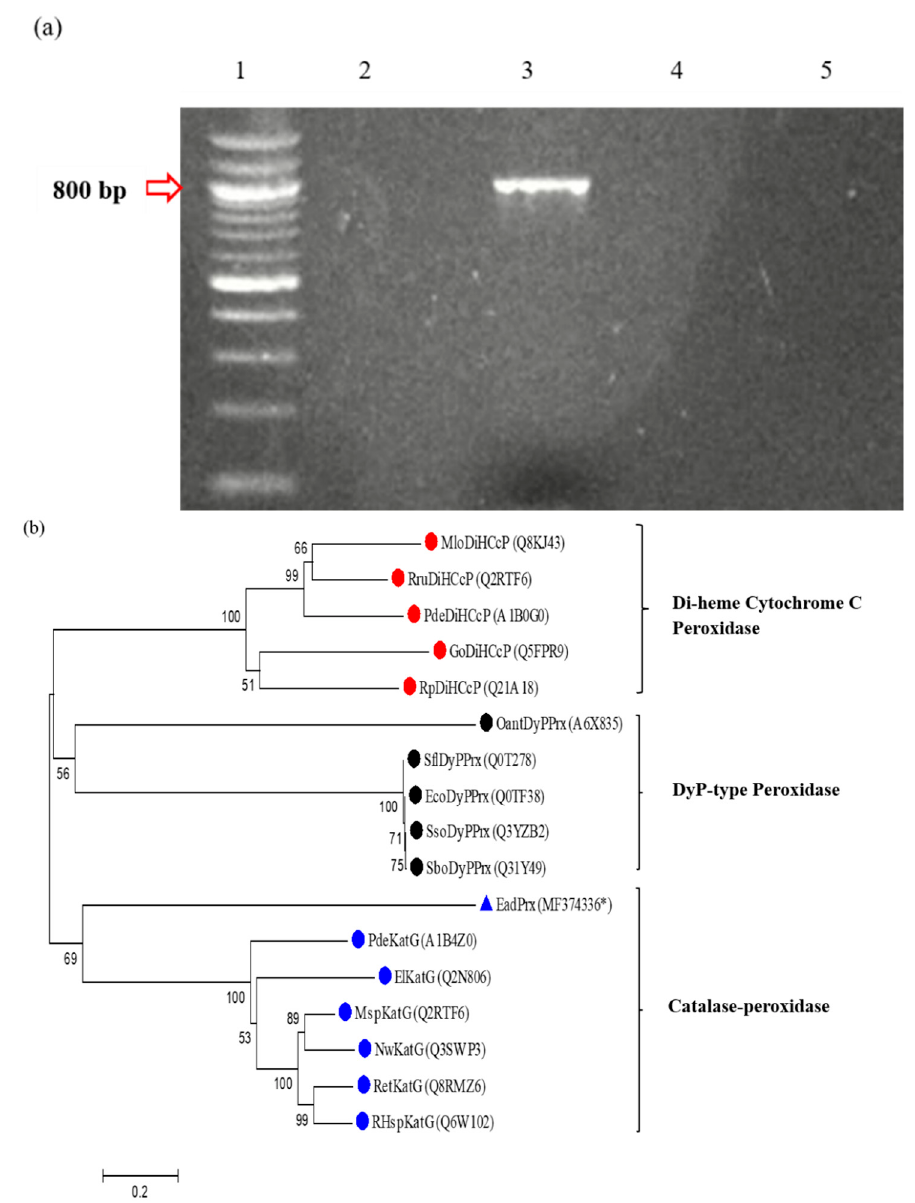
Figure 4. Molecular characterization of peroxidase in Ensifer adhaerens NWODO-2. ( a ) Gel picture of the polymerase chain reaction (PCR)-amplified product. Lane 1:100 bp DNA ladder, lane 2: Empty, lane 3: PCR-amplified product from Ensifer adhaerens NWODO-2, lane 4: Negative control. ( b ) Unrooted phylogenetic tree showing the relationship of Ensifer adhaerens NWODO-2 peroxidase with selected bacterial heme-peroxidases in the PeroxiBase. The percentage of replicate trees in which the associated taxa clustered together in the bootstrap test (1000 replicates) are shown next to the branches. Red tips indicate Di-heme cytochrome C peroxidase (DiHCcP) family, black tips indicate DyP-type peroxidase family, while the blue tips represent catalase-peroxidases. The blue triangular tip indicates the protein sequence obtained in this study (EadPrx). The UniProtKB reference numbers / GenBank accession number* of the proteins are indicated in parentheses. El: Erythrobacter litoralis , Msp: Mesorhizobium sp., Nw: Nitrobacter winogradskyi , Pde: Paracoccus denitrificans , Ret: Rhizobium etli , RHsp: Rhizobium sp., Mlo: Mesorhizobium loti , Rp: Rhodopseudomonas palustris , Rru: Rhodospirillum rubrum , Go: Gluconobacter oxydans , Eco: Escherichia coli , Sbo: Shigella boydii , Sso: Shigella sonnei , Sf: Shigella flexneri , Oant: Ochrobactrum anthropic, EadPrx: Ensifer adhaerens NWODO-2 peroxidase, DyPPrx: dye-decolourizing peroxidase, KatG: